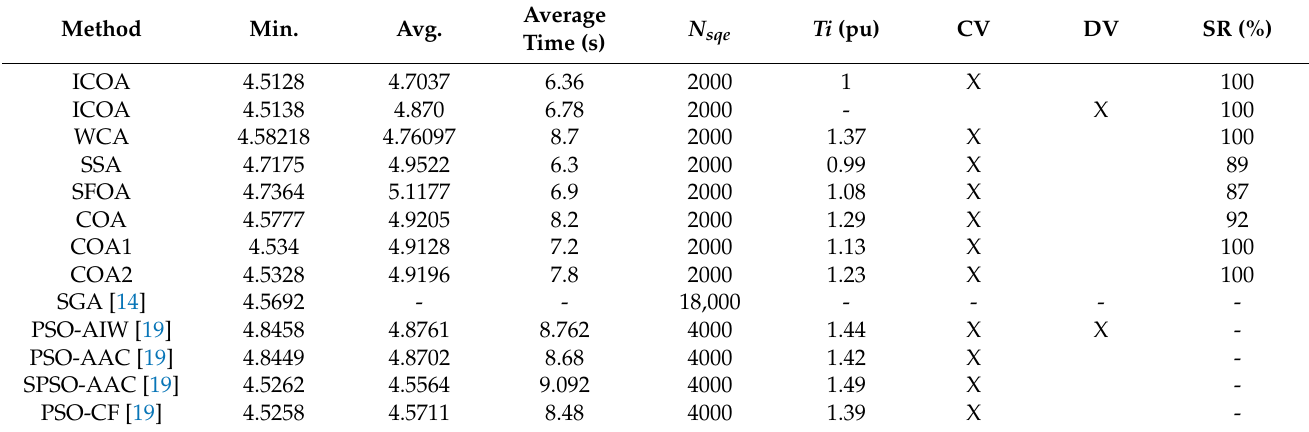
Table 5. Result comparison of TPL for the IEEE 30-bus system.